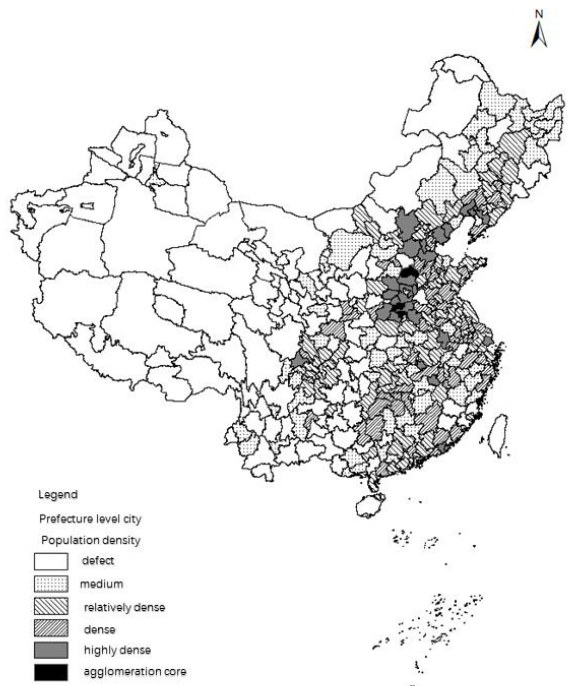
Figure 5. Annual Average Population Density Map of Chinese Prefecture-Level Cities during 2010– 2012. Data Source: China City Statistical Yearbook (2012–2013). https://www.tongjinianjian.com/111090.html (accessed on 23 December 2021).